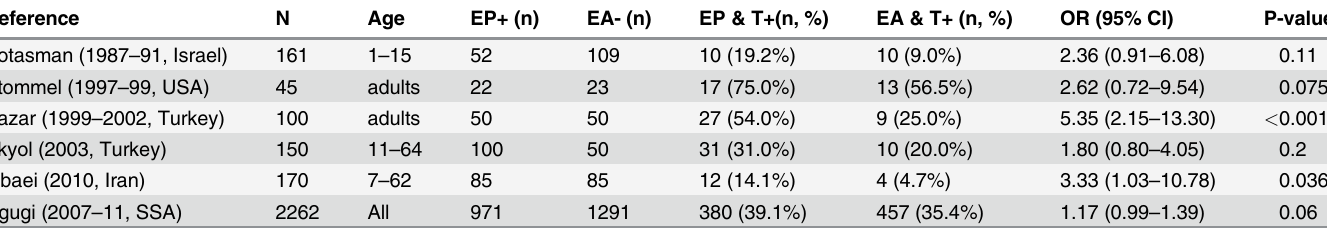
Table 2. Description of data extracted from the included studies in the meta-analysis searching for an association between toxoplasmosis and epilepsy. Reference